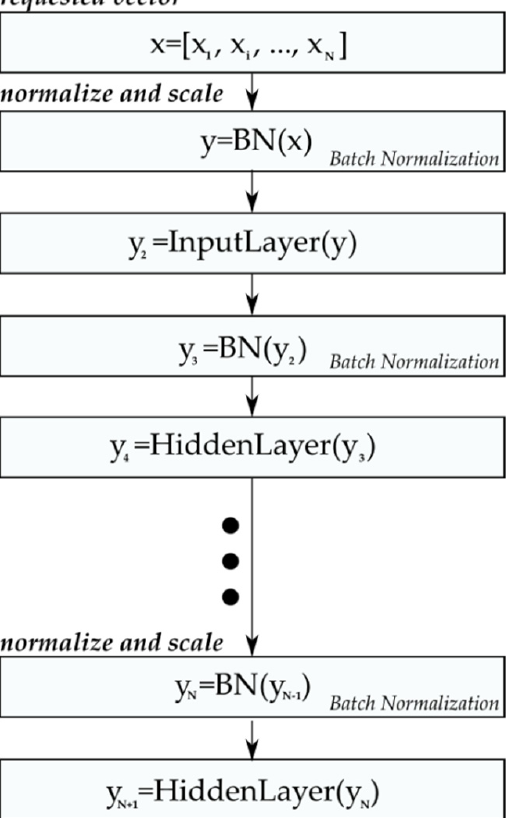
Figure 10. Scheme of normalizing the input vectors for successive layers using the batch normaliza- tion algorithm.